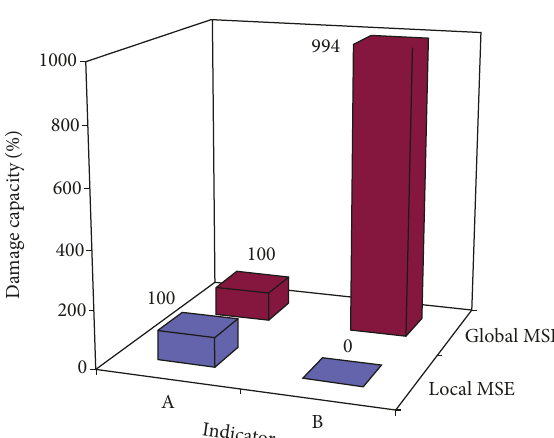
Figure 11: Damage capacity indicators for global and local procedures, using damage threshold 40% Z max